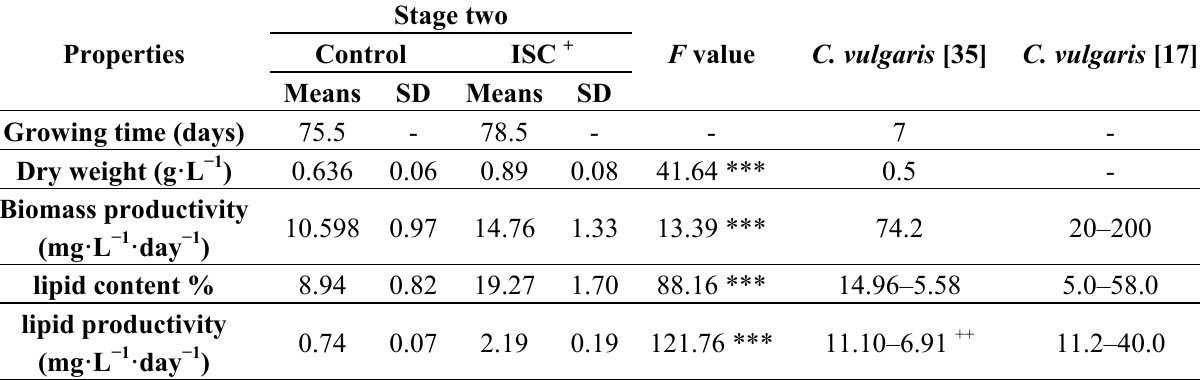
Table 2. Microalgae C. vulgaris